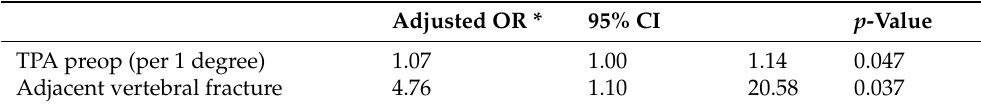
Table 4. Adjusted odds ratio for SVA > 95 mm at final